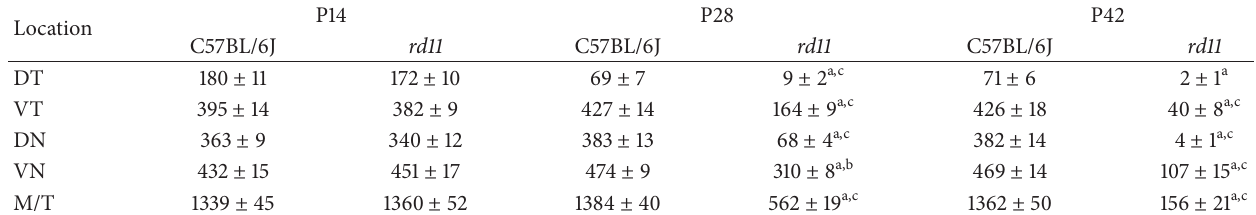
Table 3: Comparison of S-opsin density in retinal whole mounts of C57BL/6J control and rd11 mice. P14 P28 Location